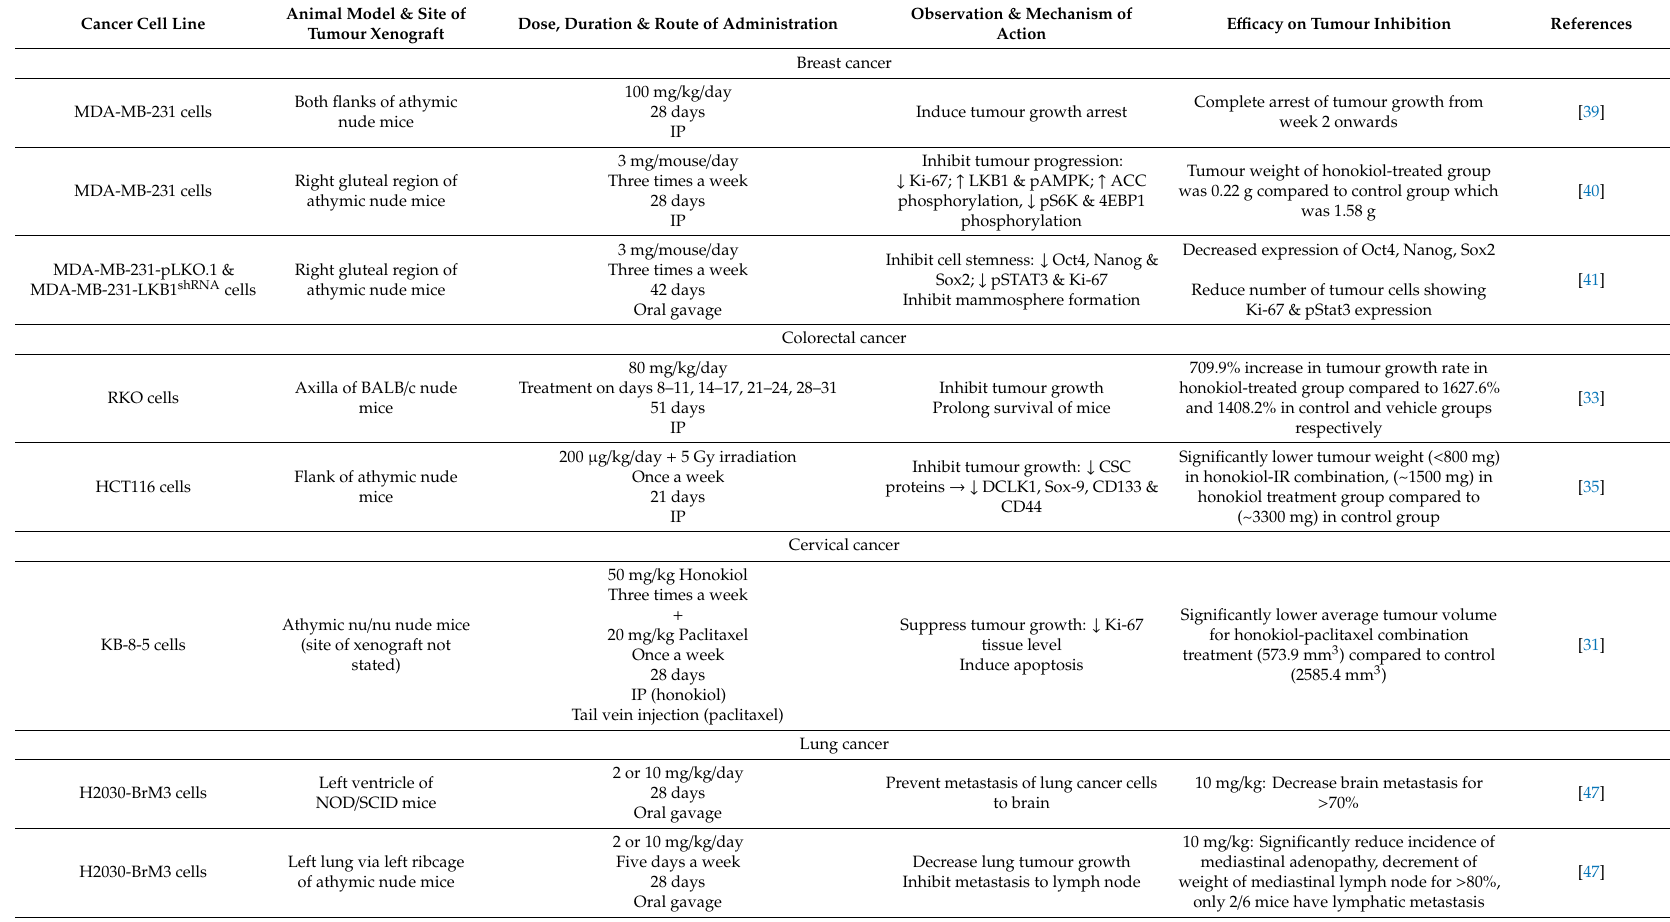
Table 2. The antitumour e ff ect of honokiol in in vivo tumour bearing animal